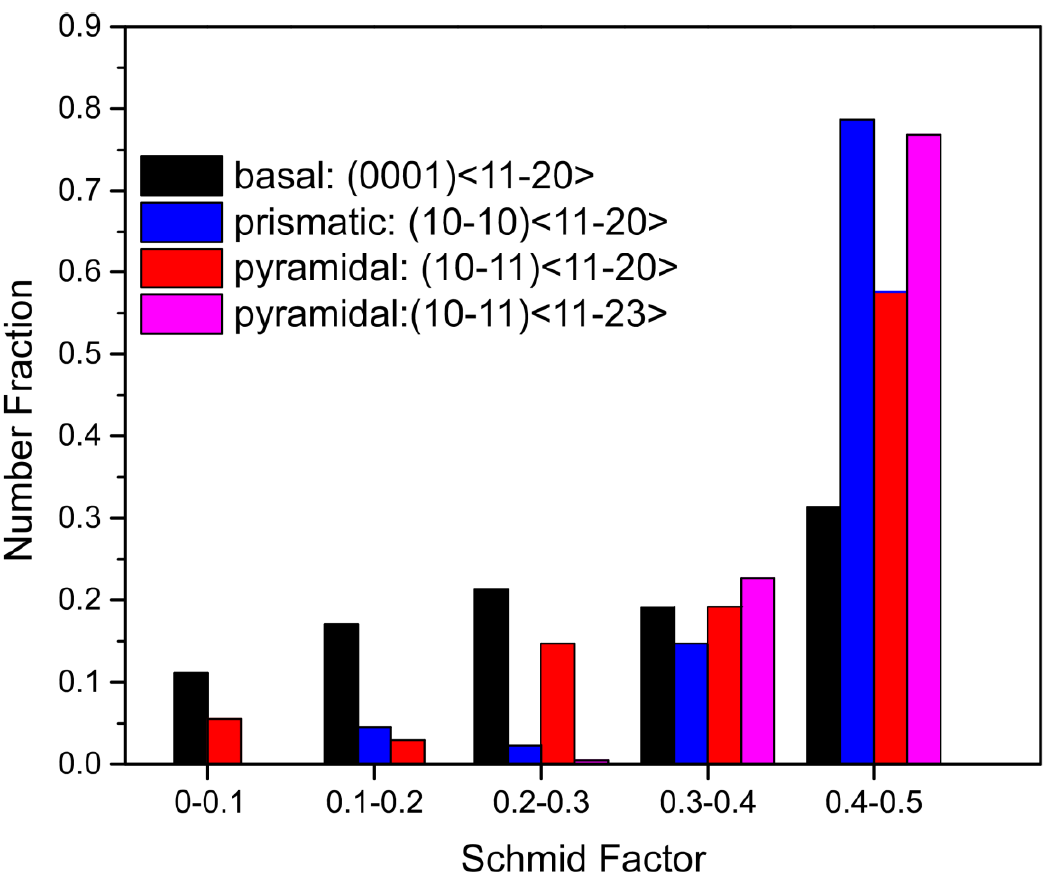
Figure 10. Statistics of the identified slip systems of the α p phase at the AOI. Table 1. The τ crss for different slip systems of the α phase .